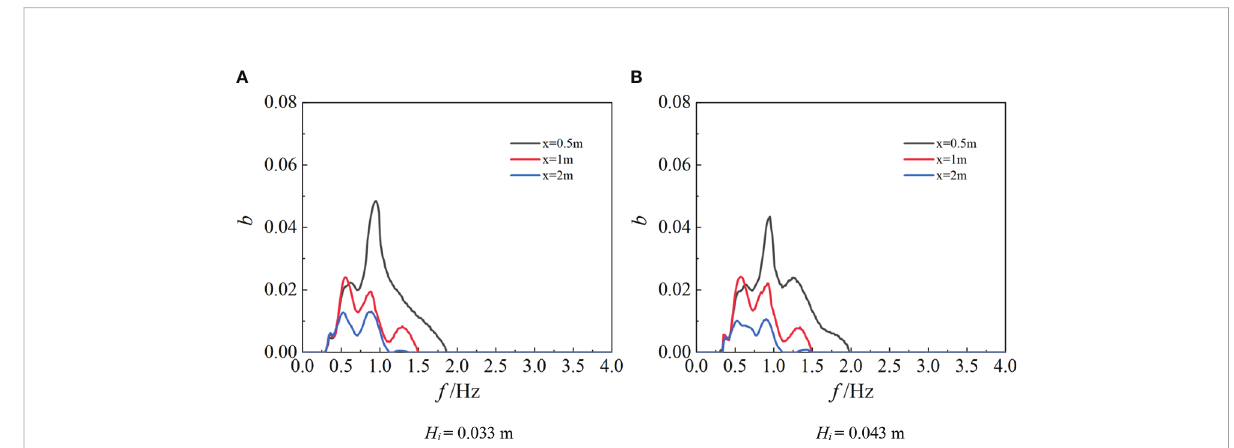
FIGURE 11 Comparison of summed bicoherence along the way (M1, D = 0.28 m, T = 1.5 s) (A) H i = 0.033 m (B) H i = 0.043